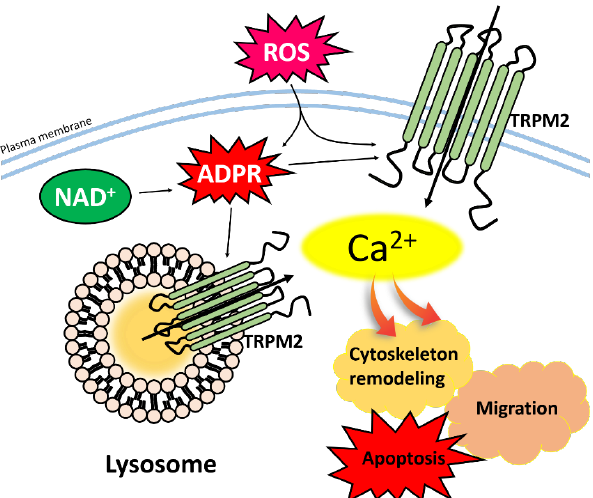
Figure 2. Activation of TRPM2 channel and cellular function. ADPR, NAD, and ROS induce up-regulation of intracellular Ca 2+ concentration through the TRPM2 and, subsequently, mediate with cell migration, cytoskeleton remodeling, and apoptosis. Abbreviations: TRPM2: Transient receptor potentials melastatin 2; ADPR: Adenosine diphosphate ribose; NAD: Adenine dinucleotide; ROS: Reactive oxygen species